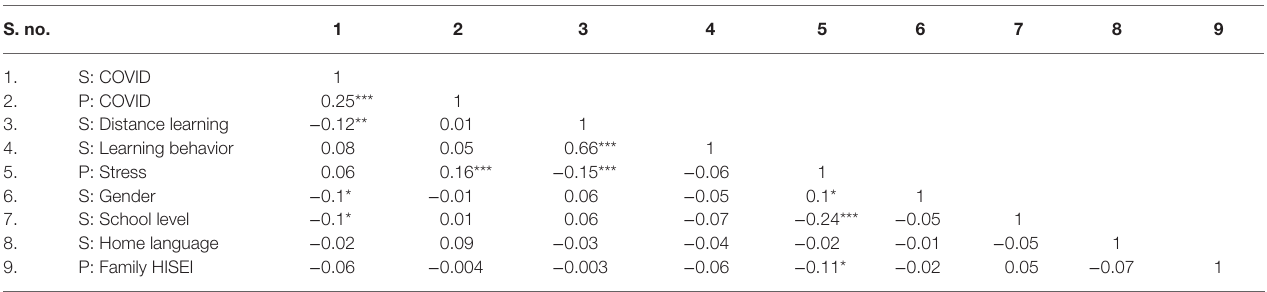
TABLE 1 | Zero-order correlations among study items at the individual